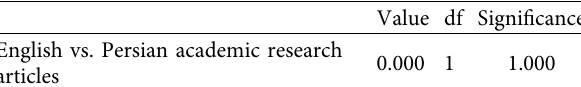
Table 4: Chi-square test for graduation resources across English and Persian academic research